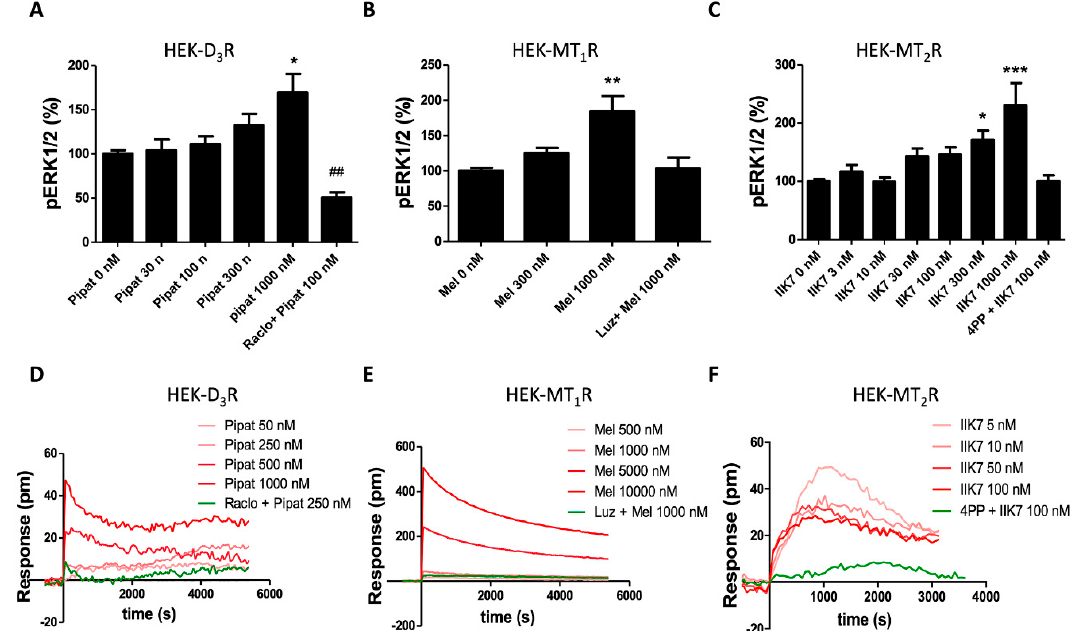
Figure A2. ERK phosphorylation and DMR responses in single-transfected HEK-293T cells. HEK-